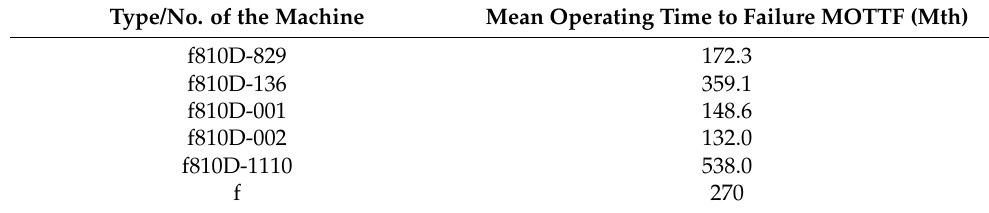
Table 4. Mean operating times to failure